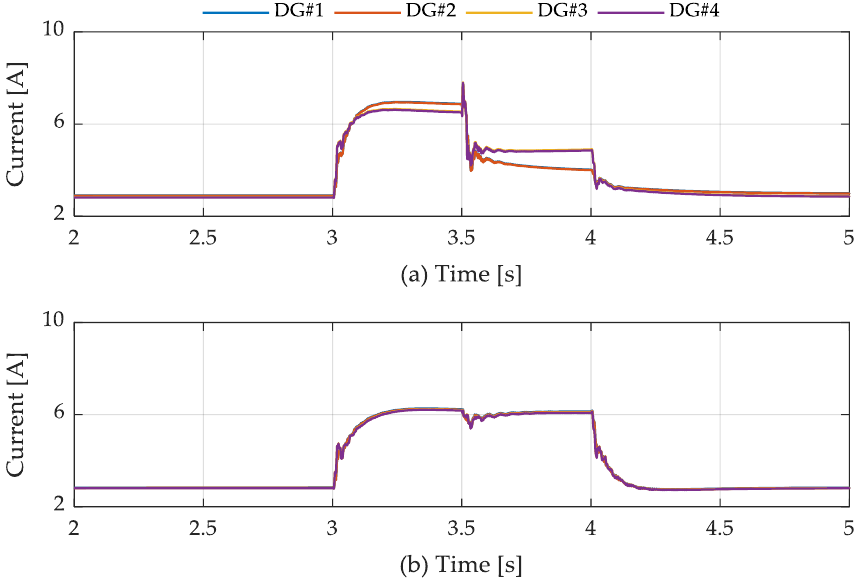
Figure 18. Output active power of each DG: ( a ) centralized method; ( b ) proposed method. 5. Conclusions This paper proposed a distributed control of DG based on dynamic consensus algorithm to improve the LVRT capability of the MG system. The proposed control method was based on a hierarchical control that consisted of a primary layer with droop control and a secondary layer with